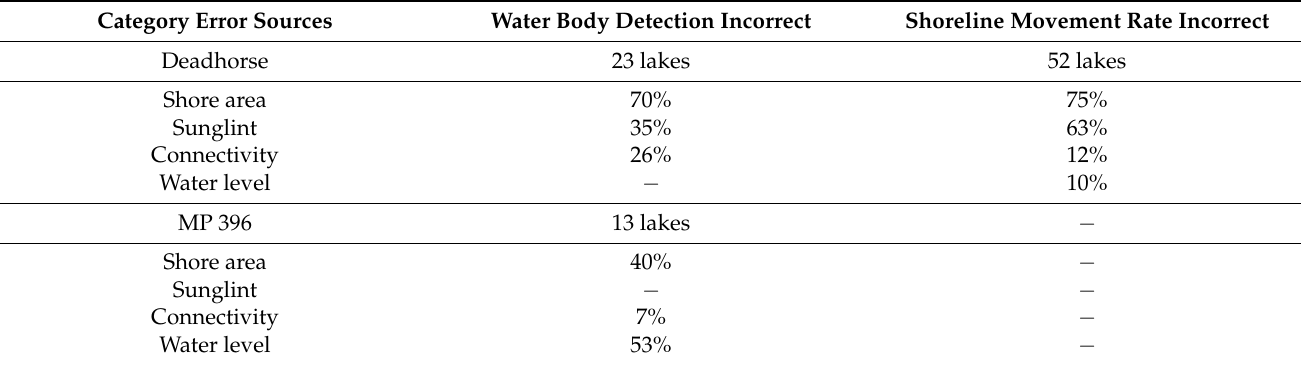
Table 3. Major error sources identified for an incorrect mapping of water bodies and calculation of shoreline movement rate. Note that water bodies show multiple reasons for an incorrect detection; therefore, the values do not add up to 100%. Category Error